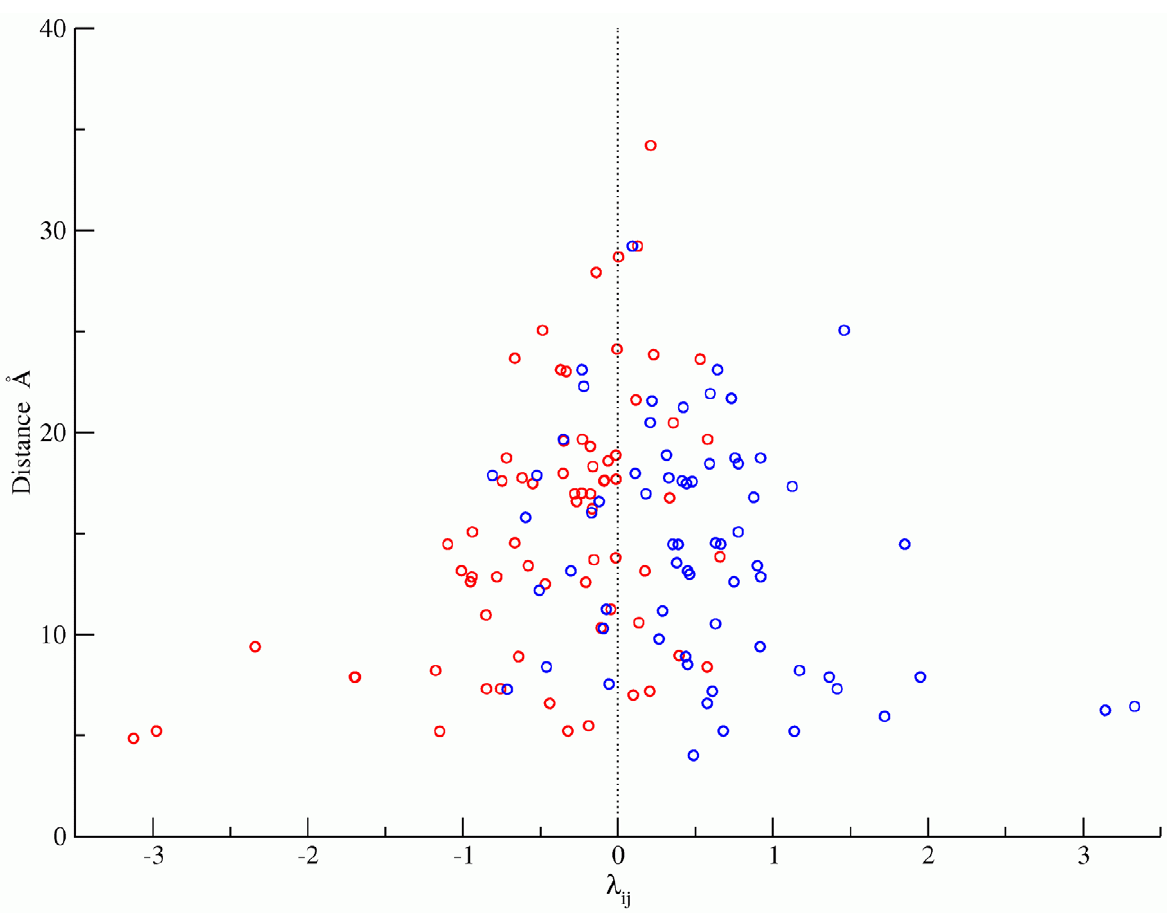
Figure 4. Distance between like and unlike-charge pairs as a function of the statistical coupling parameter, l ij . The statistical coupling parameter l ij is a fitting parameter that describes the statistical interaction energy between pairs of states. Since the Bethe mean field pair correlation model is a good approximation for this data, a negative l ij indicates that a pair of states is enhanced (positively correlated), while a positive l ij indicates that a pair of states is suppressed (negatively correlated). Using simple electrostatics, we observe that like-charge patterns (blue) are mostly suppressed while unlike-charge patterns (red) are enhanced. The sign of l ij is able to correctly predict the charge patterns for & 90% of the top 35 most significantly correlated charge pairs out of a total of 135 pairs. The p-value for the statistical significance of this result is & 10 { 5 . The reason there are 135 pairs is as follows: For each pair of residues, there are 4 possible sets of like and unlike charge combinations, resulting in a total of 612 like/unlike charge pair combinations. However, not all pairs exist in the database or are significantly correlated. Filtering results in 135 pairs with probability greater than